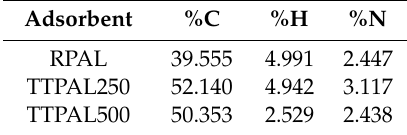
Table 5. CHN Elemental analysis of the prepared adsorbents.